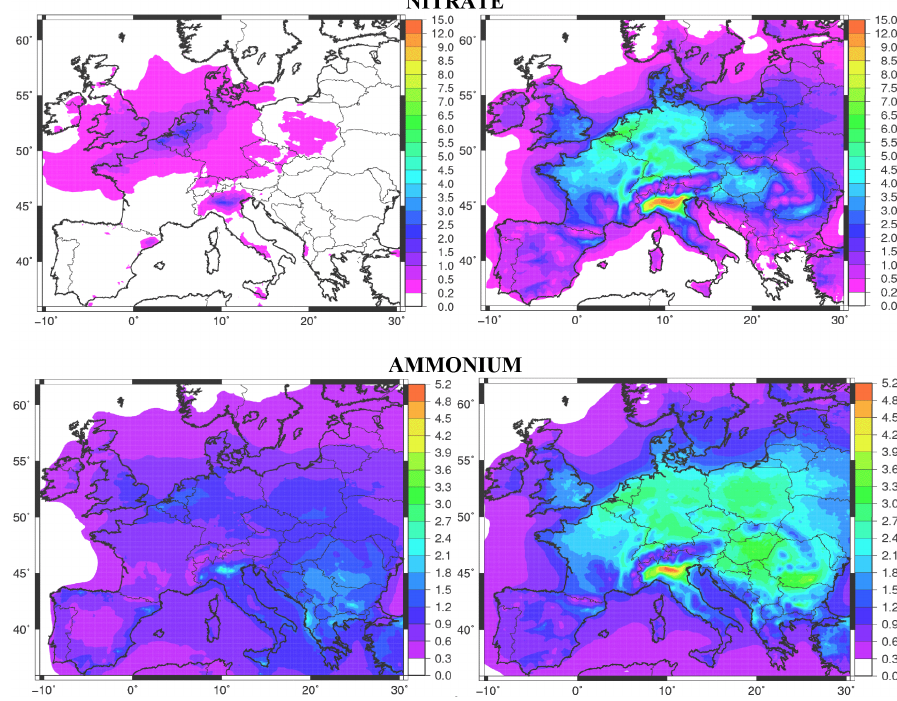
Figure 11. Modelled nitrate and ammonium (µgm − 3 ) concentrations fields calculated for the summer (left) and the winter (right)